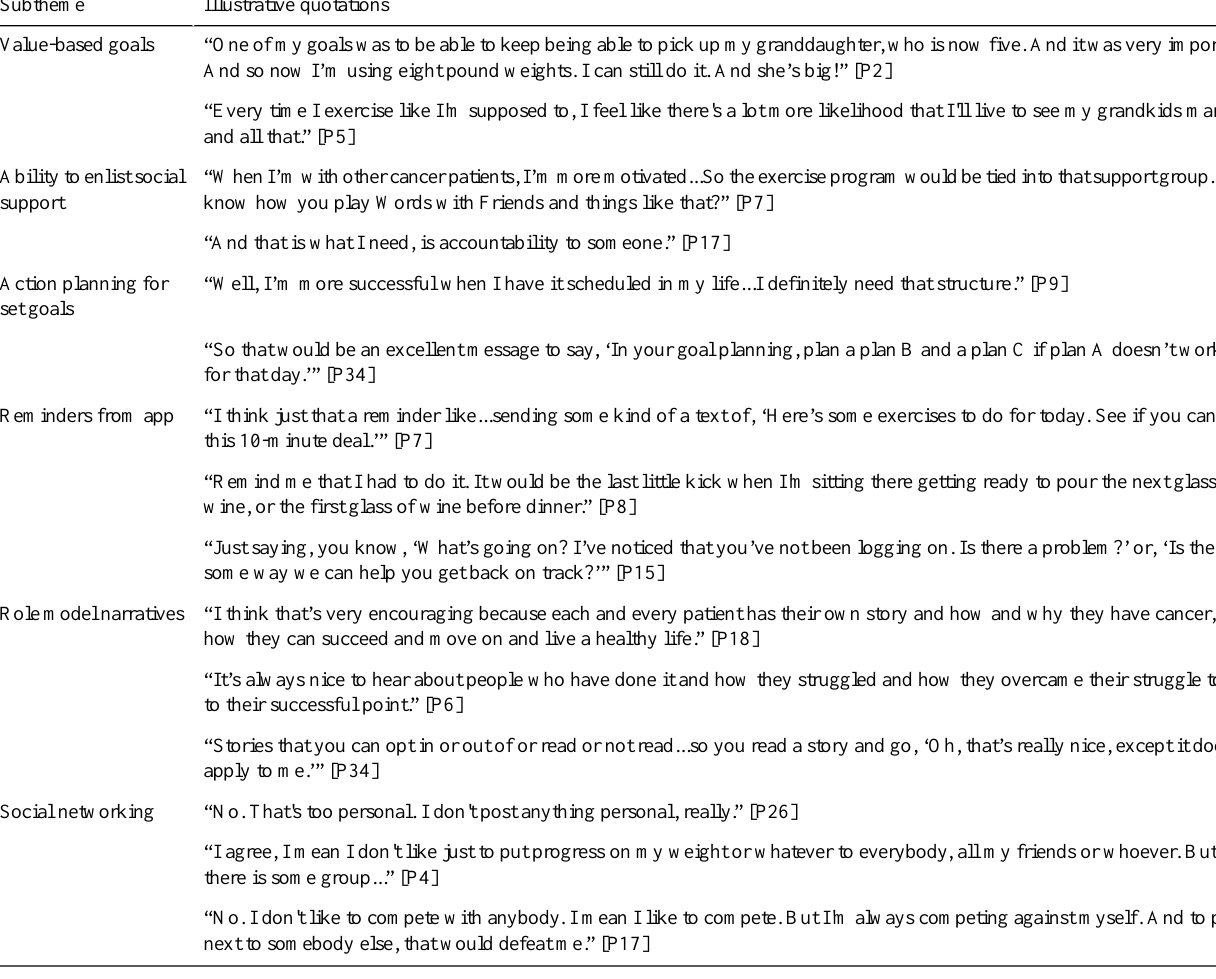
Table 3. Tools for personal goal